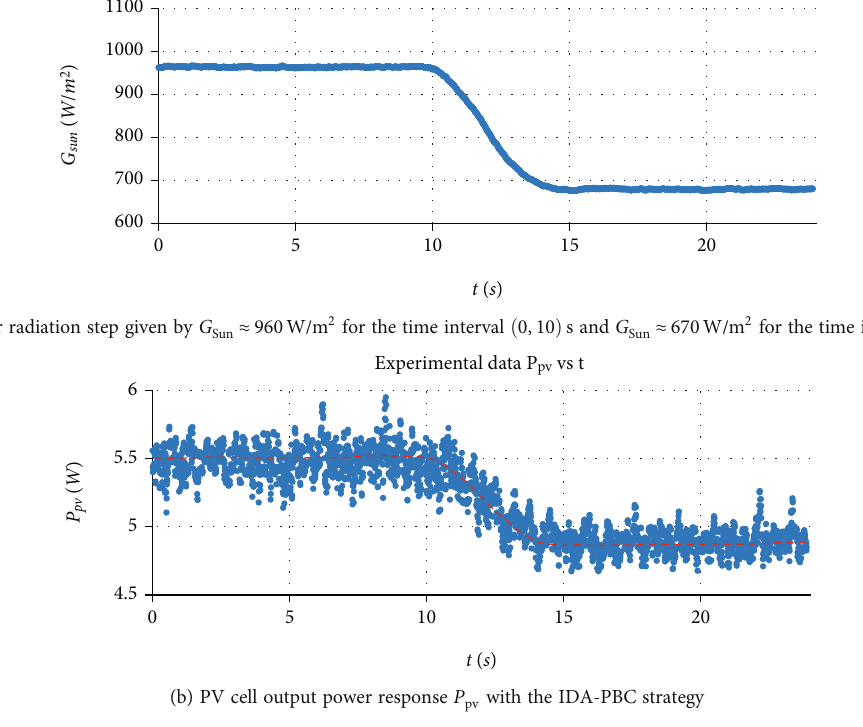
Figure 10: Experimental data of the PV cell output power response to a given input power radiation with the IDA-PBC strategy implemented into a hardware